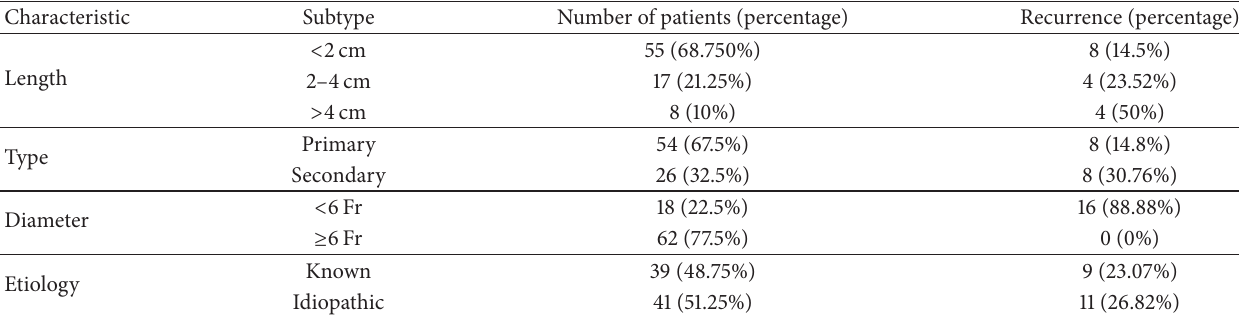
Table 1: Distribution of recurrence with respect to various characteristics of bulbar urethral